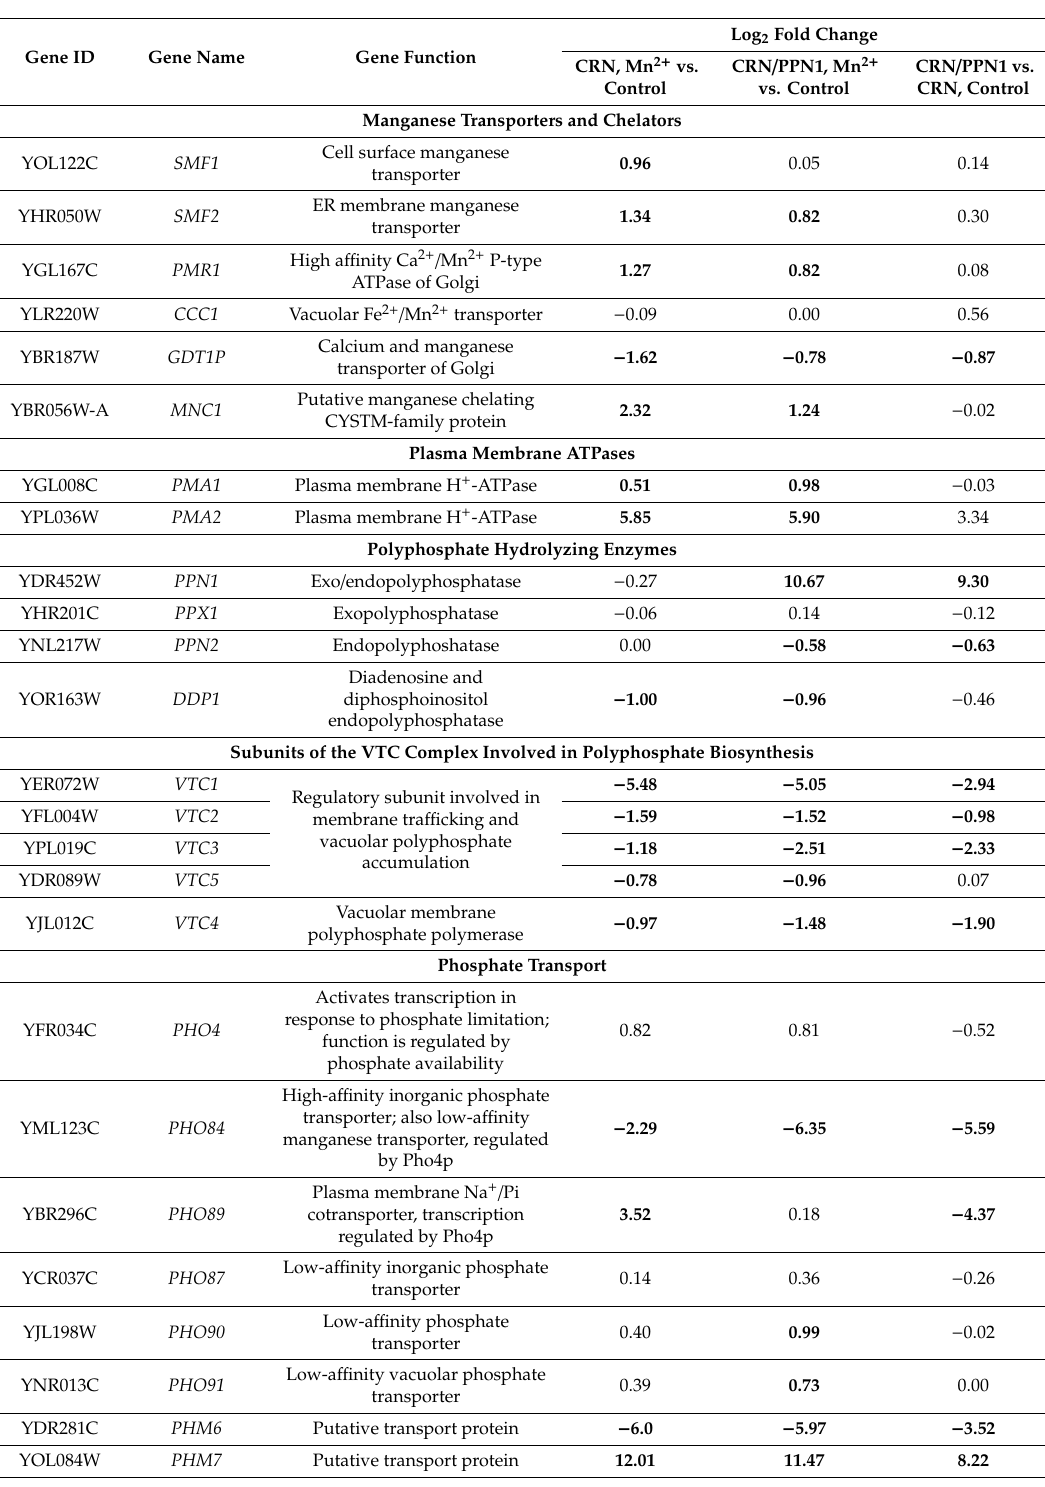
Table 1. Di ff erential expression of the selected genes responsible for manganese transport and belonging to the PHO pathway. The cases of di ff erential expression with FDR-corrected p -value ≤ 0.05 are marked in